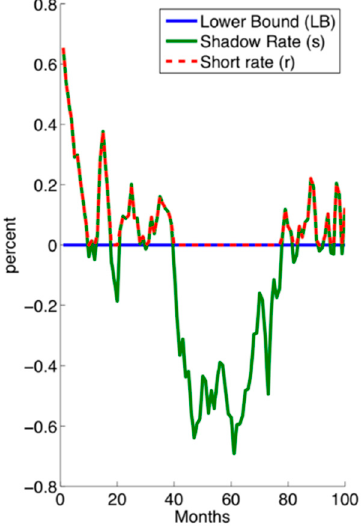
Figure 2. Short rate and shadow rate association (adopted from Lemke and Vladu 2017).